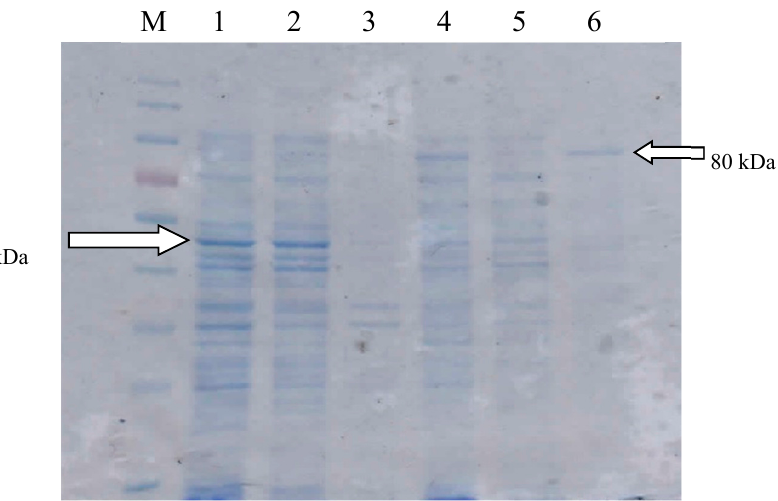
Figure 1. SDS-PAGE of intracellular Candida antarctica lipase A (CALA) and surface-display CALA. Lane M: Marker; Lanes 1–3: Whole cells, supernatant, and pellet of intracellular CALA, respectively; Lanes 4–6: Whole cells, supernatant, and pellet for surface-display CALA (sdCALA), respectively.